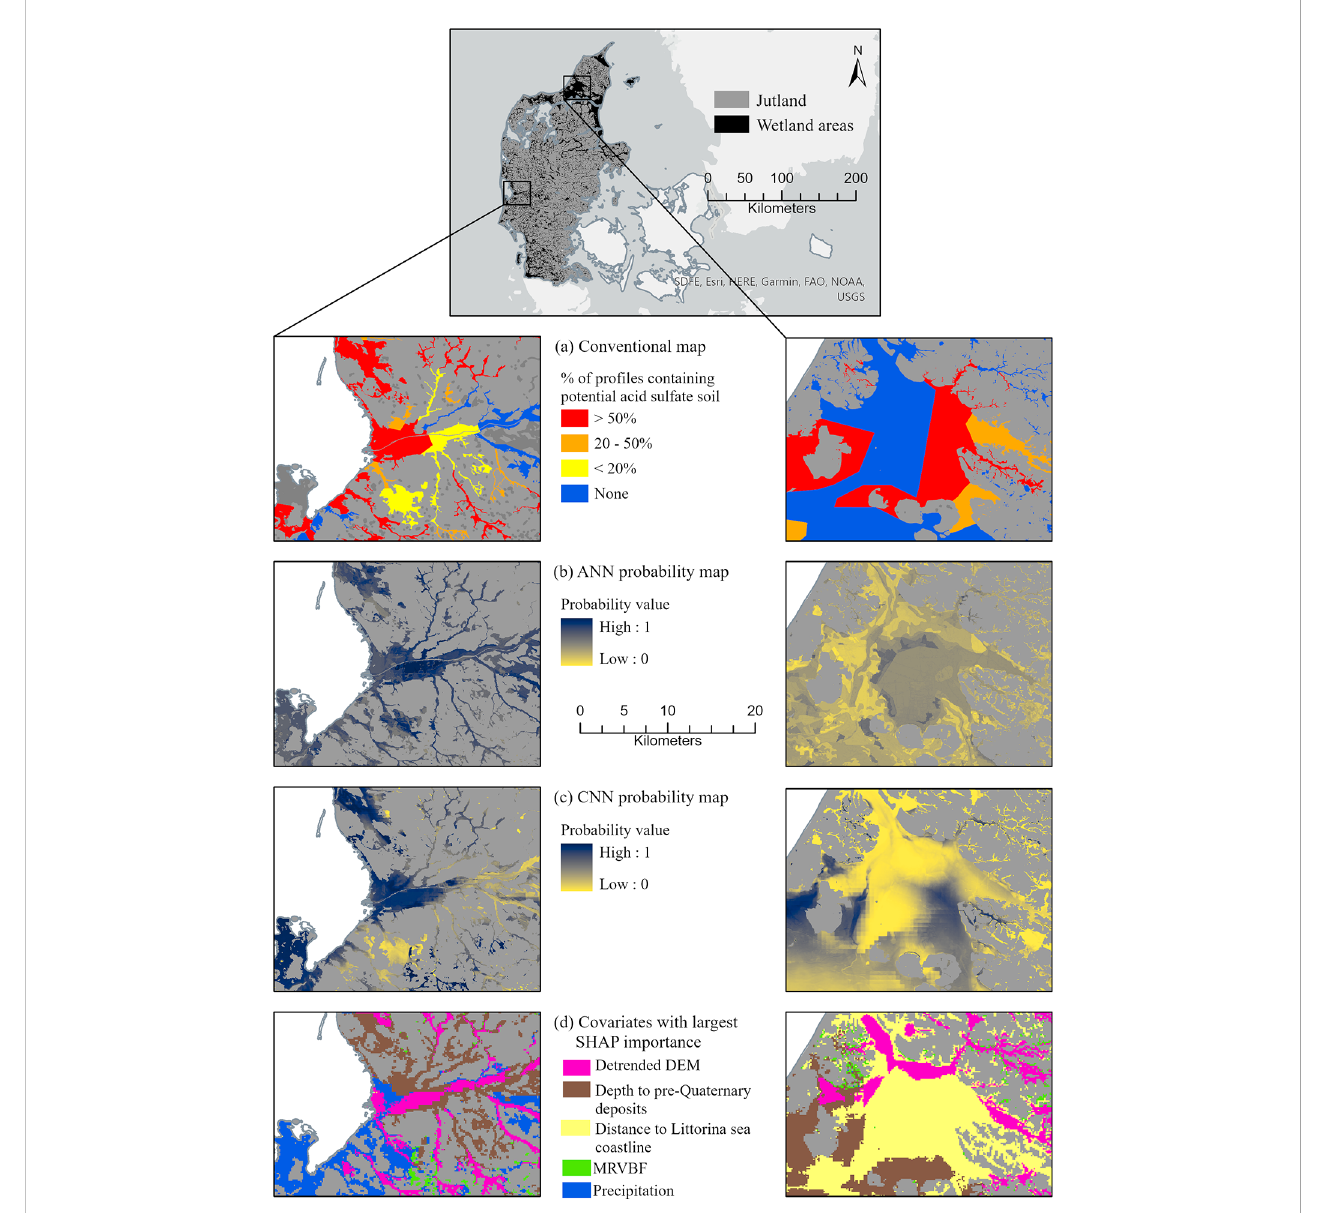
FIGURE 6 Mapping occurrence of potential acid sulfate soils for the Skjern River catchment area (left) and the Store Vildmose raised bog area (right): (A) conventional map, probability maps created with (B) arti fi cial neural networks (ANN) and (C) convolutional neural networks (CNN), and (D) covariates with the largest SHAP importance within the CNN